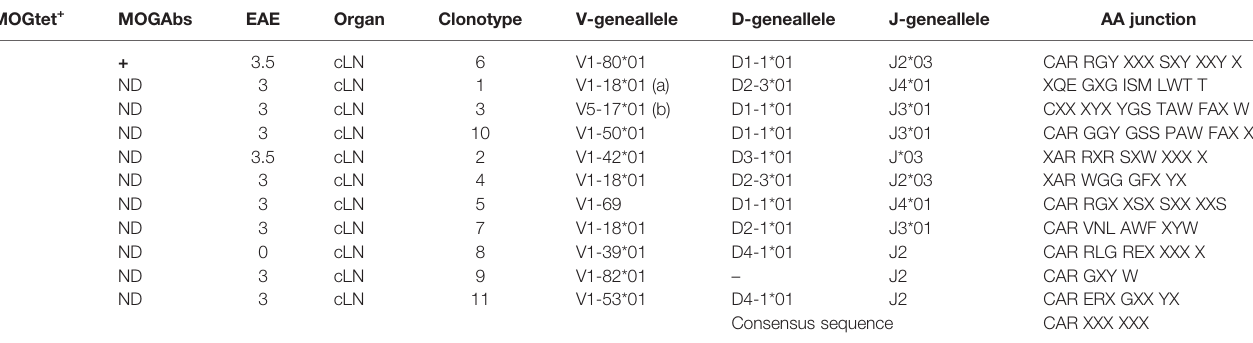
TABLE 1 | VDJ rearrangements and junctional sequence of the IgG heavy chain of clonal iGB B cells. MOGtet